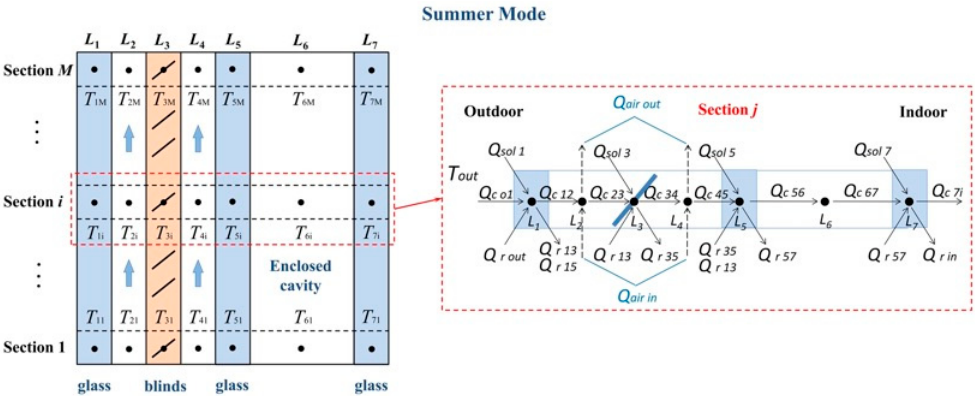
Figure 2. Discretization of the EAGU in summer. Each section consists of seven zones including three glazing panes (L 1 , L 5 , L 7 ), venetian blinds (L 3 ), ventilated air layers at the outside and inside of venetian blinds (L 2 , L 4 ), and enclosed air layer (L 6 ). Considering the convection, long-wave radiation, and solar radiation, energy balance equations of the seven zones for each section can be developed. In this study, the formulation of energy balance equations is explained in detail for the i th section and can be used to develop the energy balance equations for the whole window.